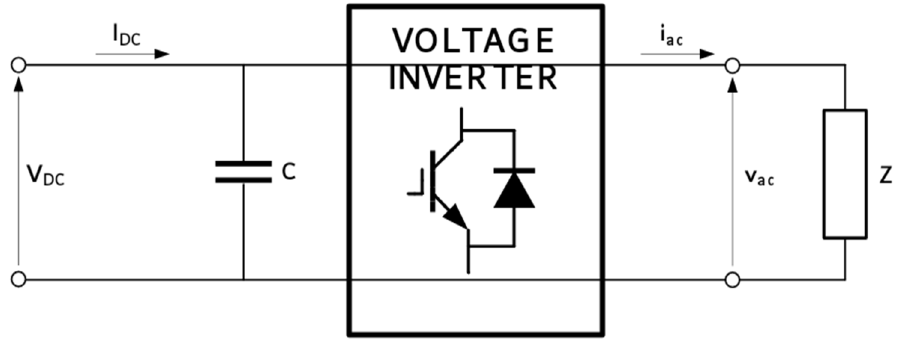
Figure 7. DC/AC inverter design.